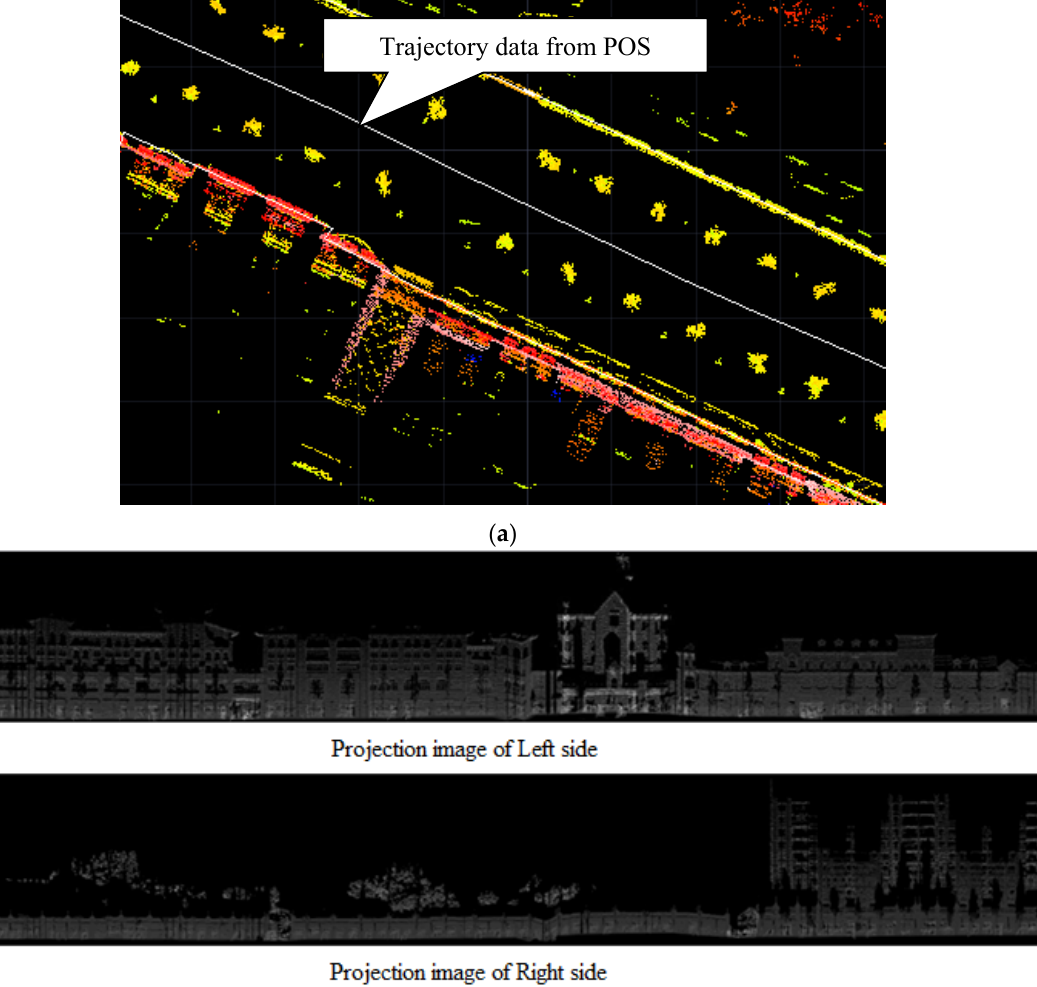
Figure 4. Facade projection results based on position and orientation system (POS) trajectory. ( a ) Point cloud projection image from top view; ( b ) Facade projection image.